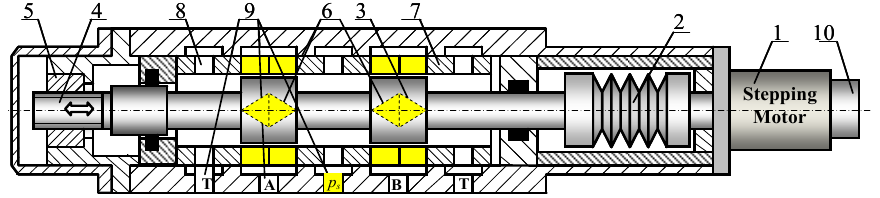
Figure 2. The valve with one stepping motor (the gaps are marked with yellow color) [28]. In this valve, instead of solenoids, a stepping motor (1) is used, which is connected with an elastic clutch (2) to the spool (3) located in a valve sleeve. On the other side (left) of the valve, the spool is ended with a threaded shaft (4), which is screwed into the element (5). Thanks to this screw connection, the rotational movement turns into linear, and as a result, the spool linear displacement is proportional to the number of steps made by the stepping motor. The shifting of the spool results in opening or closing of the triangular gaps (6) between the spool and a sleeve (7). The valve body has grooves (8) machined on a drill, which connect the valve windows. The hydraulic inputs and outputs (9) are as follows: p s —supply pressure; T—tank; A, B—cylinder ports (chambers). The position of the stepping motor rotor is measured by an encoder (10).